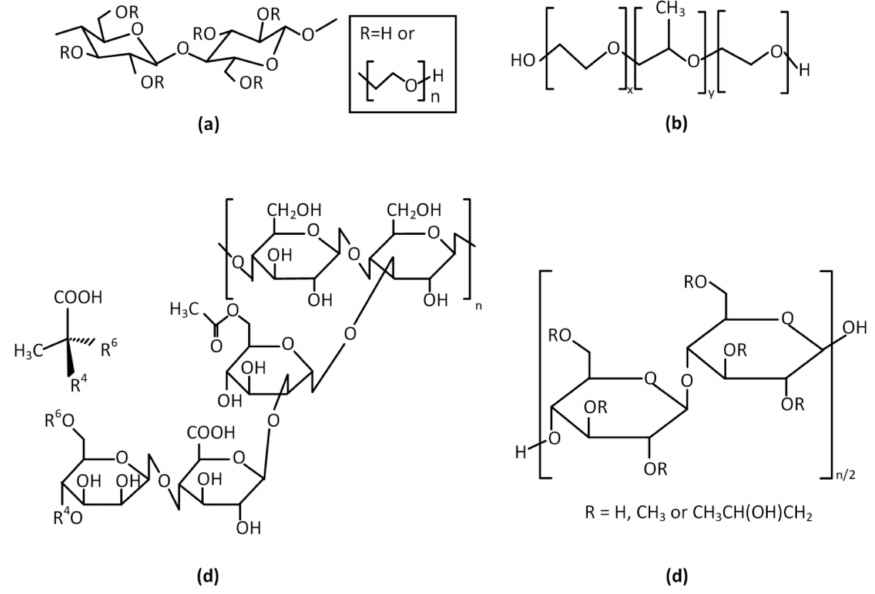
Figure 3. Structures of commonly used polymers for artificial saliva: ( a ) hydroxy ethylcellulose (HEC); ( b ) poloxamer or Pluronic ® (PEO-PPG-PEO); ( c ) xanthan gum; ( d ) hydroxypropyl methylcel- lulose